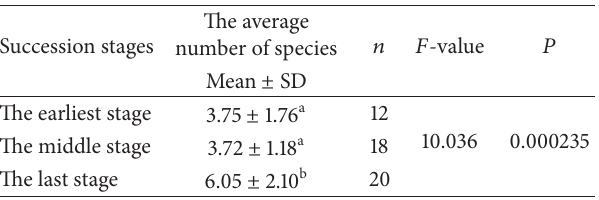
Figure 3: PCA ordination diagram of 50 plots in three succession stages of communities on the foreland of Glacier-BS1 at Mt. Yulong. Assoc. 1–3.4 represent nine associations of herbaceous plants in three succession stages produced by Twinspan. Table3:One-wayANOVAoftheaveragenumberofspeciesinthree succession